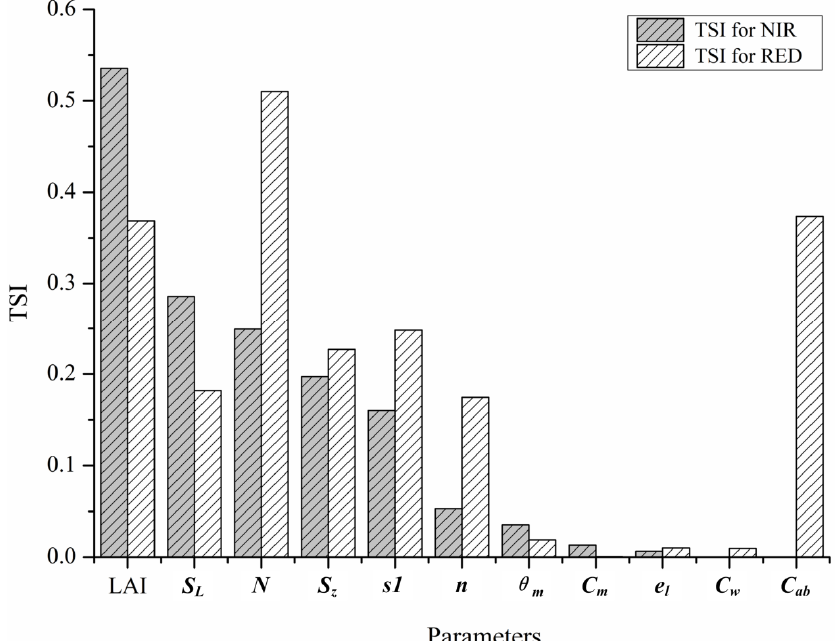
Figure 3. Sensitivity analysis of key input parameters of ACRM at near-infrared (NIR) and RED wavebands using Sobol’s method. TSI stands for total sensitivity